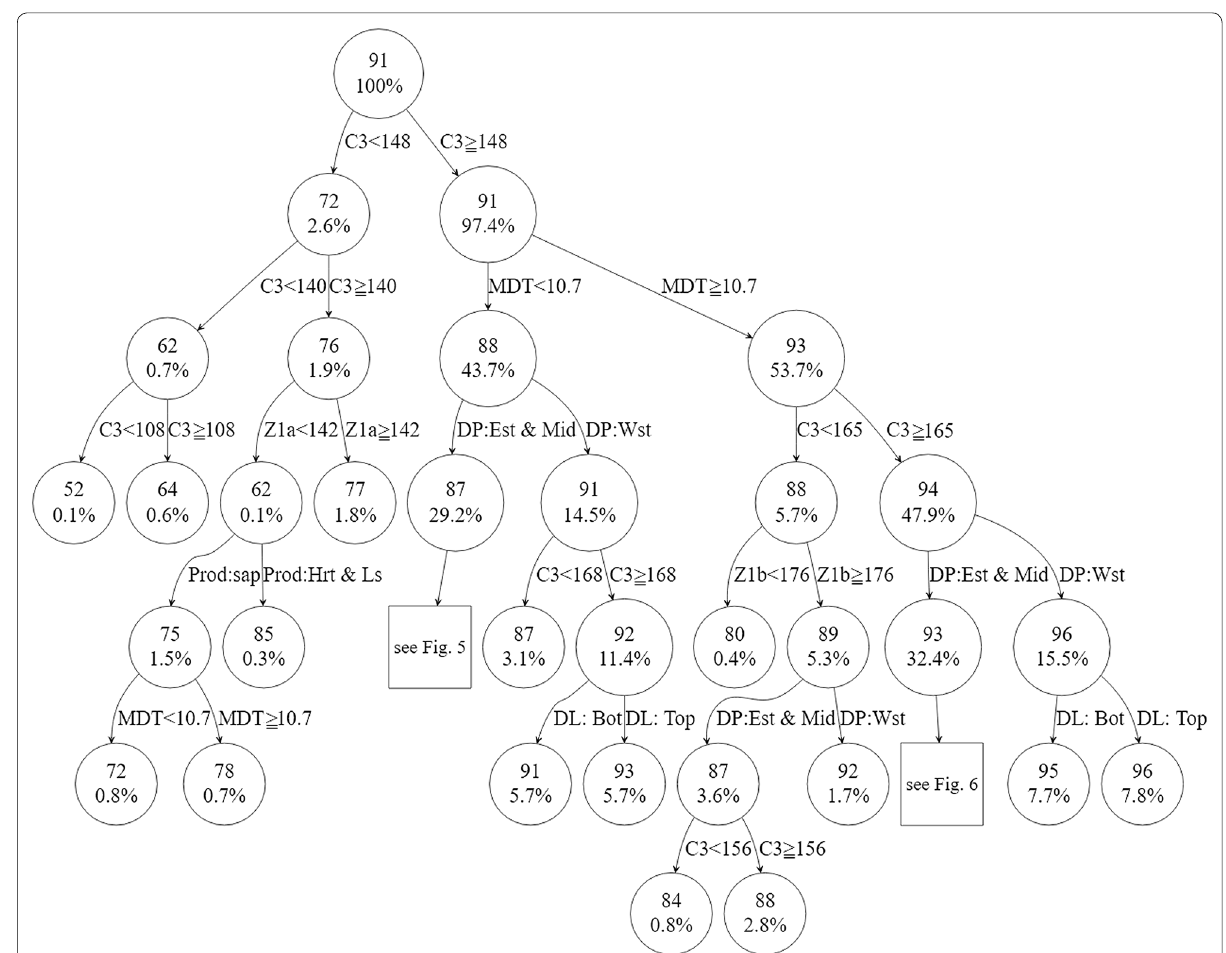
Fig. 4 Fitted optimal regression tree of temperature of veneer. The value inside the circles indicates the veneer temperatures in °C and the percentage of the